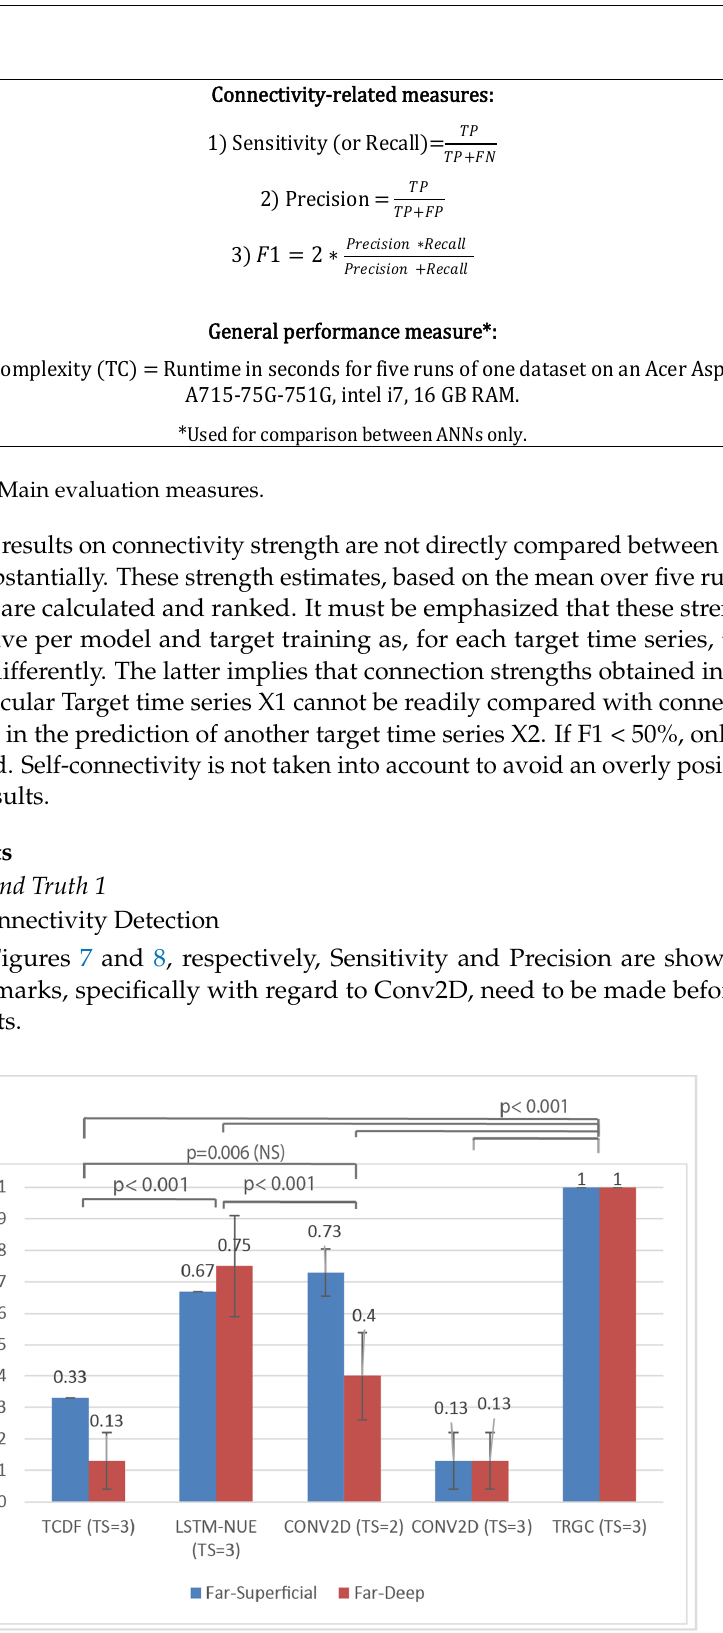
Figure 7. Mean Sensitivity for all methods (L = 1500). Sensitivity Ranking Far–Superficial: TRGC > Conv2D (TS = 2) > LSTM-NUE > TCDF > Conv2D (TS = 3). Sensitivity Ranking Far–Deep: TRGC > LSTM-NUE > Conv2D (TS = 2) > Conv2D (TS = 3) = TCDF. Abbreviation TS = amount of time series included in the